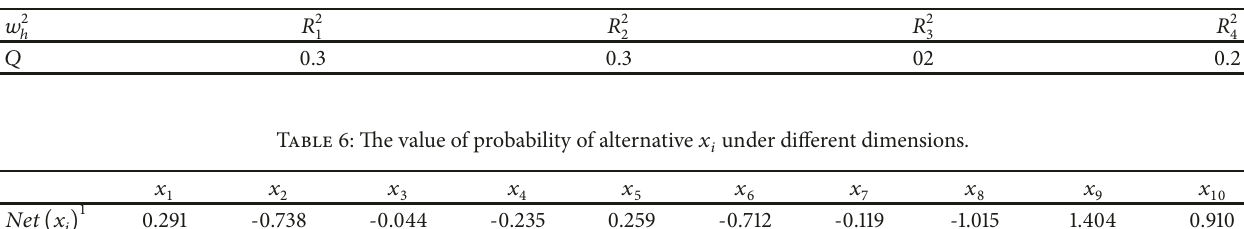
Table 5: The weight of the patients group to the dimensions of reputation.